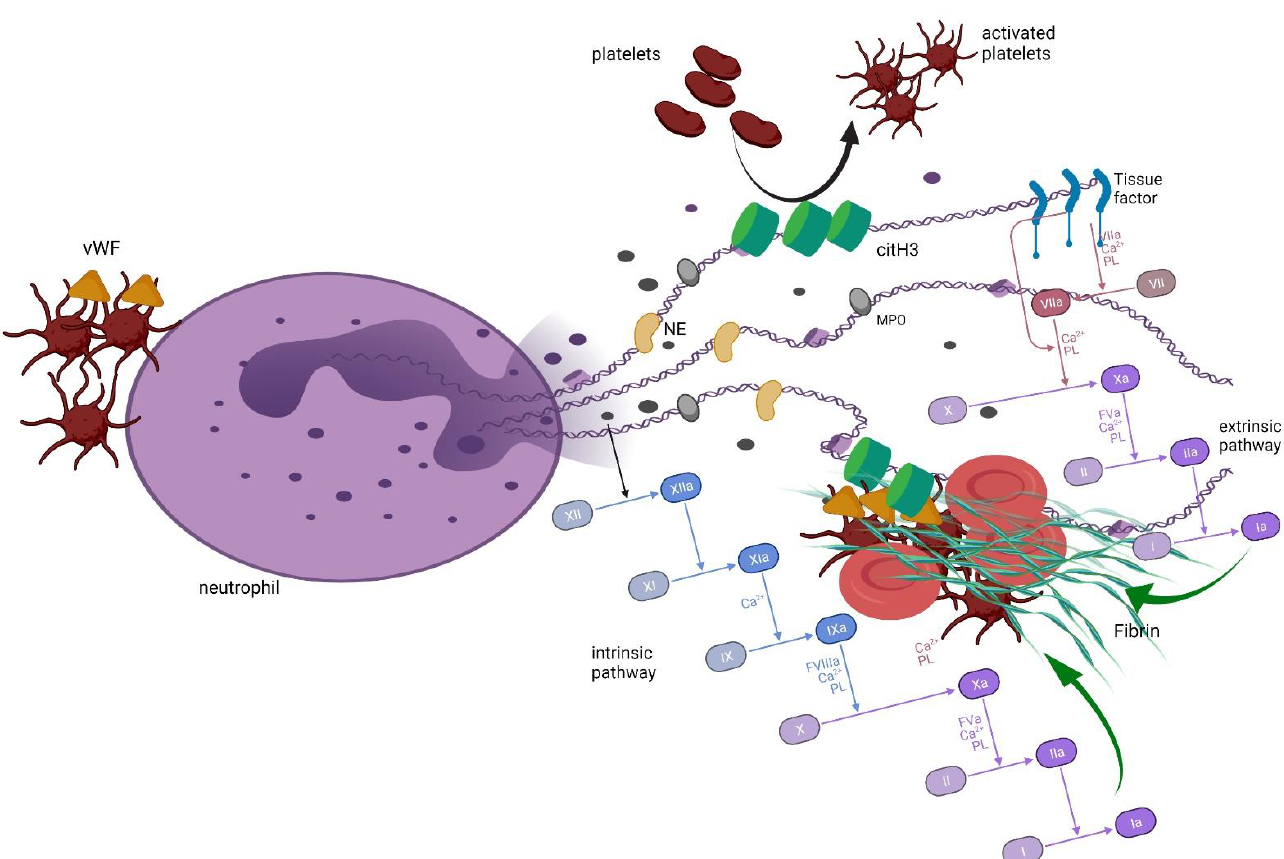
Figure 2. The role of NETs in inducing coagulation and formation of thrombi. Activated platelets may induce neutrophils to release NETs. Citrullinated histones activate platelets, which leads to activation of coagulation. Moreover, DNA from NETs become a scaffold for thrombus generation by attaching red blood cells and activated platelets. Negative charge of DNA threads activate FXII, inducing intrinsic pathway of coagulation. Tissue factor that is exposed in the NETs structure activates extrinsic pathway of coagulation. NETs, neutrophil extracellular traps; FXII, coagulation factor XII; NE, neutrophil elastase; MPO, myeloperoxidase; vWF, von Willebrand factor; citH3, citrullinated histone 3. The figure was generated using BioRender.com (22 September 2021).